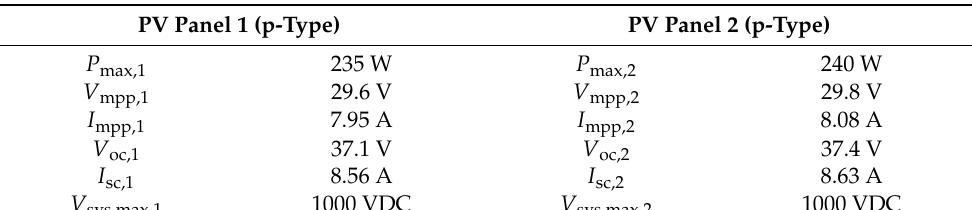
Table 2. Photovoltaic panels’ characteristics.